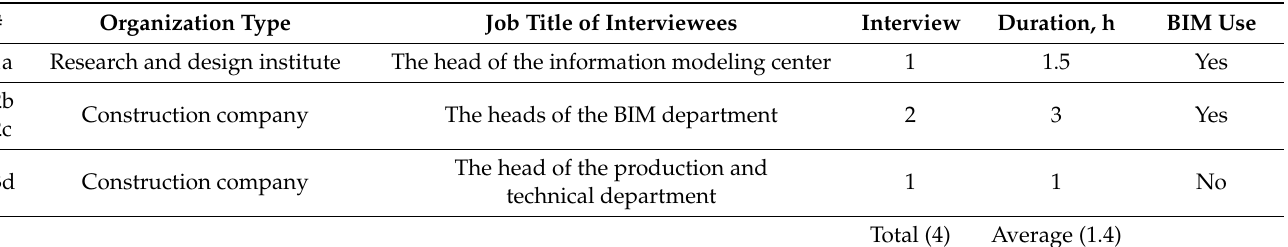
Table 3. List of